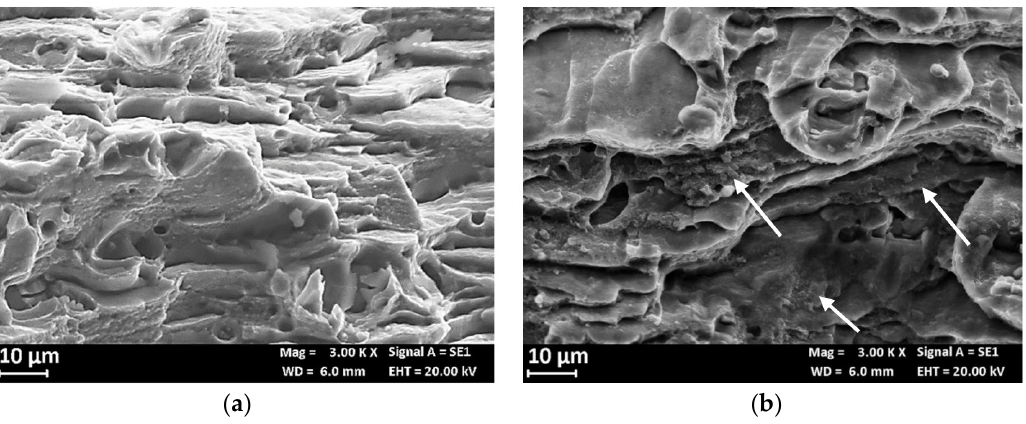
Figure 16. SEM image of the fracture surface of the AA7075 T6 specimen after the SSR test: ( a ) particular of the fracture surface at air and ( b ) in 0.6M NaCl solution (the arrows indicate small areas with typical SCC morphology).